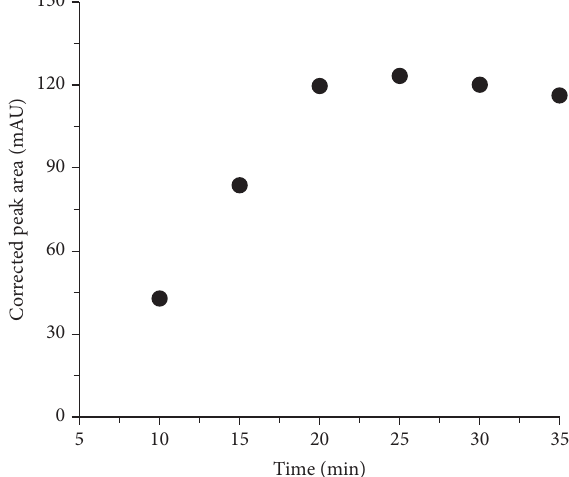
Figure 6: The influence of the time on extraction yield (expressed as corrected peak